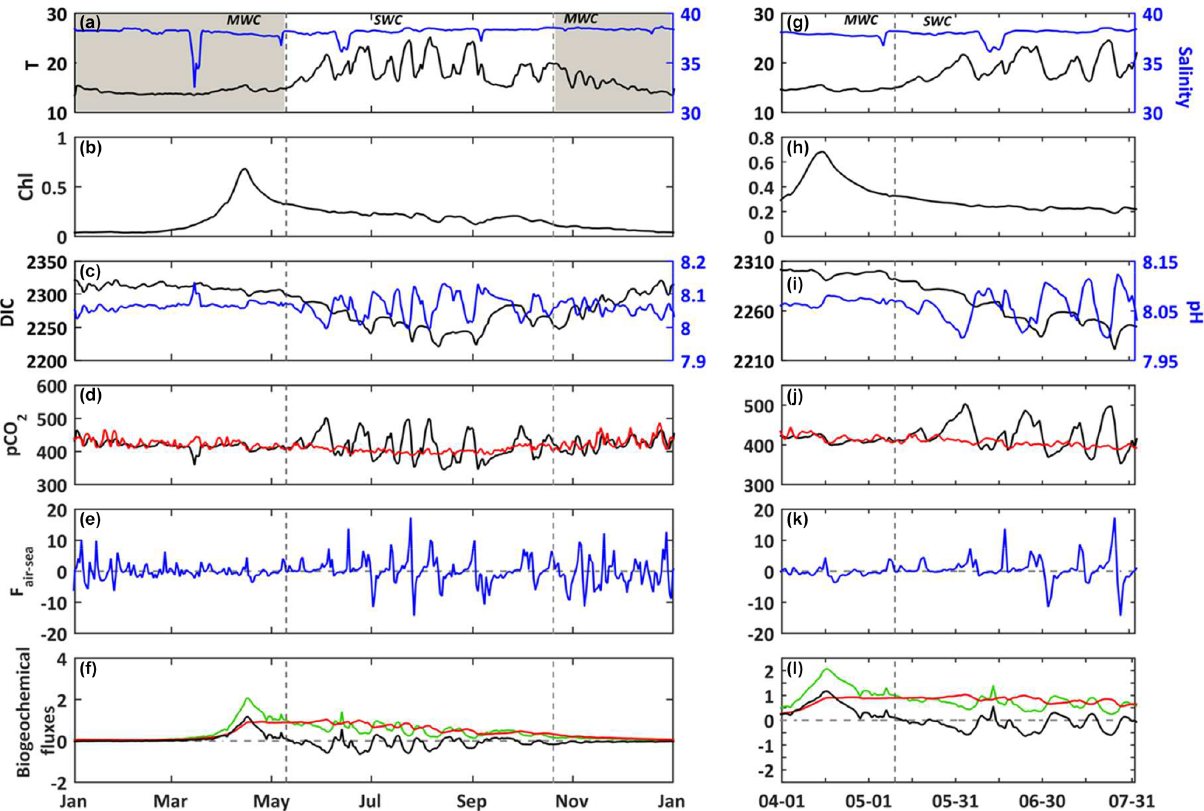
Figure 4. (a–f) 2017. (g–l) Temporal focus between 1 April and 31 July 2017. In situ daily average of (a, g) temperature ( ◦ C, black line) and salinity (blue line) at the SOLEMIO station (at the surface). Modeled daily average (b, h) chlorophyll a concentrations (mgm − 3 , black line) (c, i) DIC (µmolkg − 1 , black line) and pH (blue line), (d, j) seawater p CO 2 (µatm, black line) and atmosphere p CO 2 from OHP (µatm, red line), (e, k) air–sea CO 2 fluxes (mmolm − 3 d − 1 ), (f, l) gross primary production (mmolm − 3 d − 1 , green line), total respiration (mmolm − 3 d − 1 , red line) and net ecosystem production (mmolm − 3 d − 1 , black line). The shaded areas and dotted black lines delimit the SWC and MWC periods.